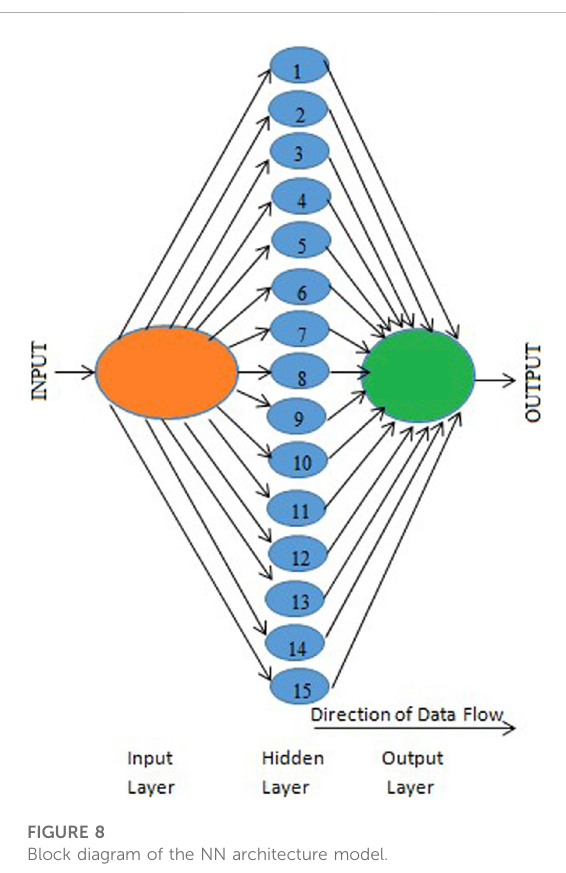
FIGURE 8 Block diagram of the NN architecture